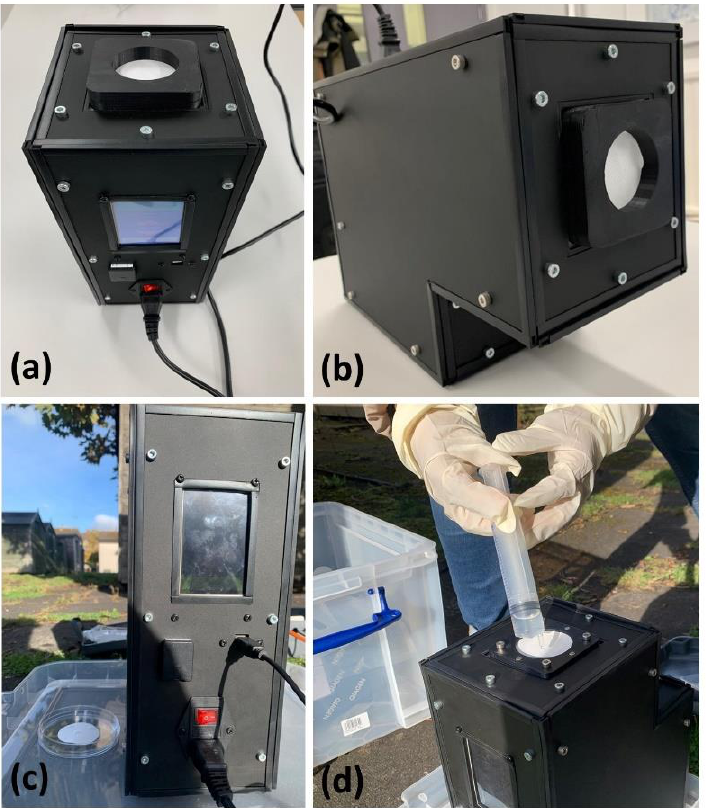
Figure 5. ( a , b ) Bioaerosol sampler loaded with the 47 mm diameter filter; ( c ) sampling in an outdoor environment; and ( d ) 1X PBS added to moisten the filter.